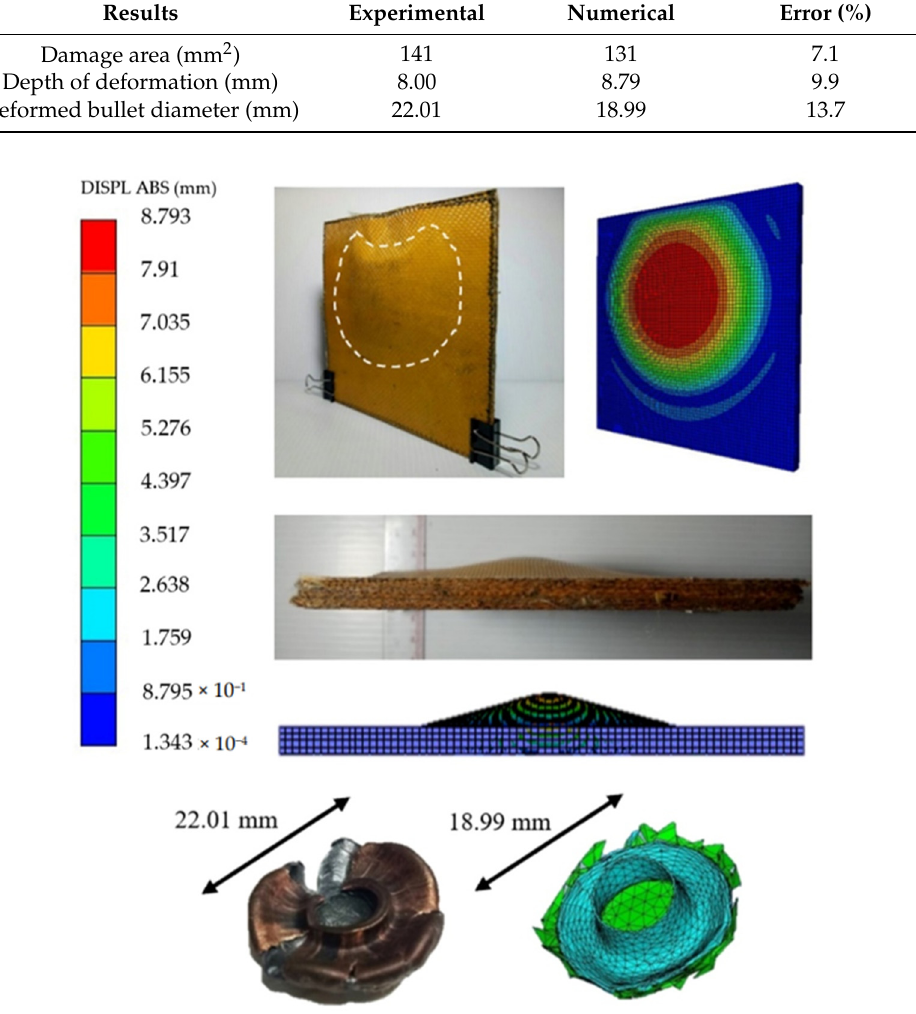
Table 6. Comparison on experimental and simulation results of the nanocomposite laminate.